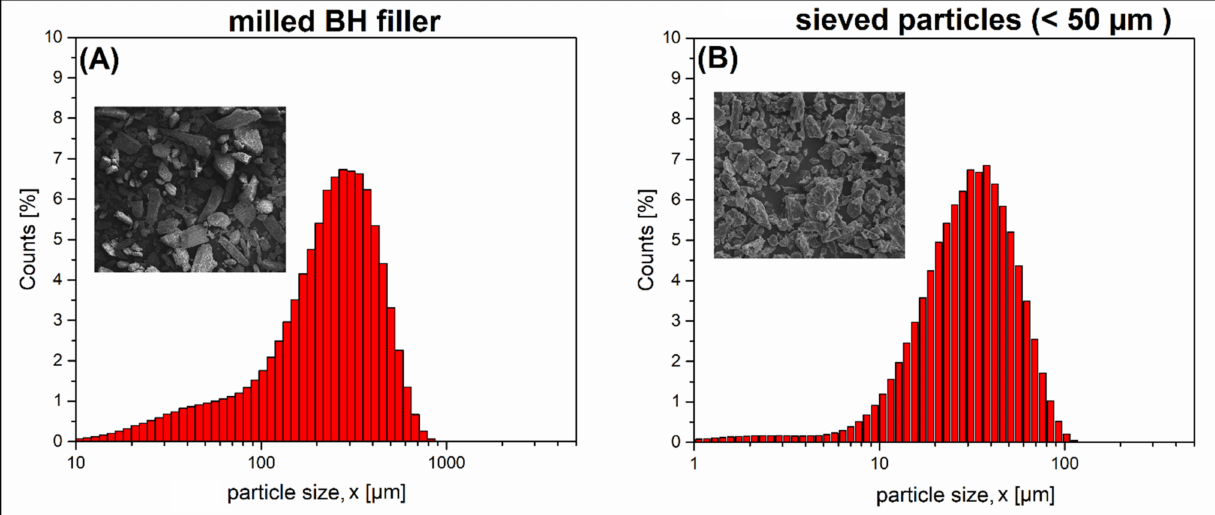
Figure 2. The particle size distribution obtained for ( A ) milled BH particles, and ( B ) sieved BH particles (<50 µ